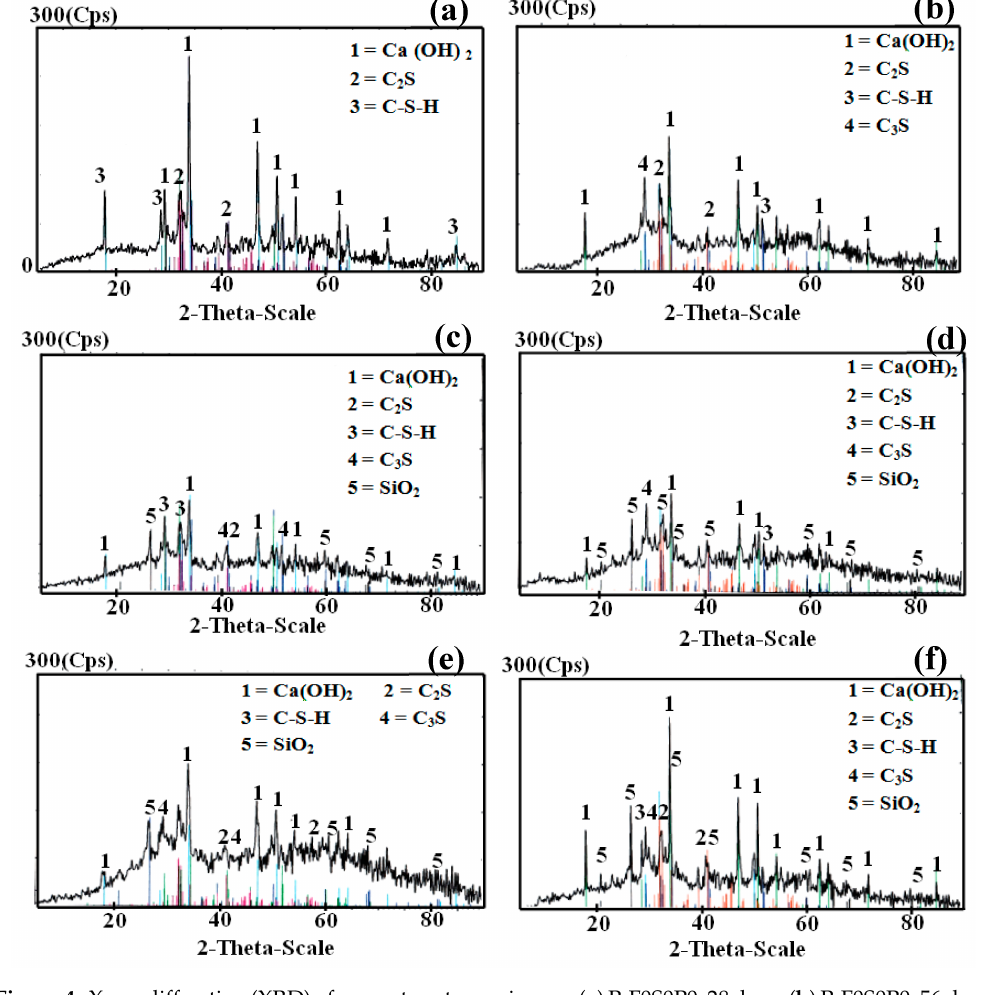
Figure 4. X-ray diffraction (XRD) of cement paste specimens: ( a ) P-F0S0P0, 28 days; ( b ) P-F0S0P0, 56 days; ( c ) P-F20S10P0.4, 28 days; ( d ) P-F20S10P0.4, 56 days; ( e ) P-F30S0P0.4, 28 days; and ( f ) P-F30S0P0.4, 56 days. 1: portlandite Ca(OH) 2 ; 2: larnite Ca 2 SiO 4 ; 3: calcium silicate hydrate Ca · 5SiO 3 · 5H 2 O; 4: calcium silicate Ca 3 SiO 5 ; 5: quartz SiO 2 ; 6: ettringite Ca 6 Al 2 (SO 4 ) 3 (OH) 12 · 26H 2